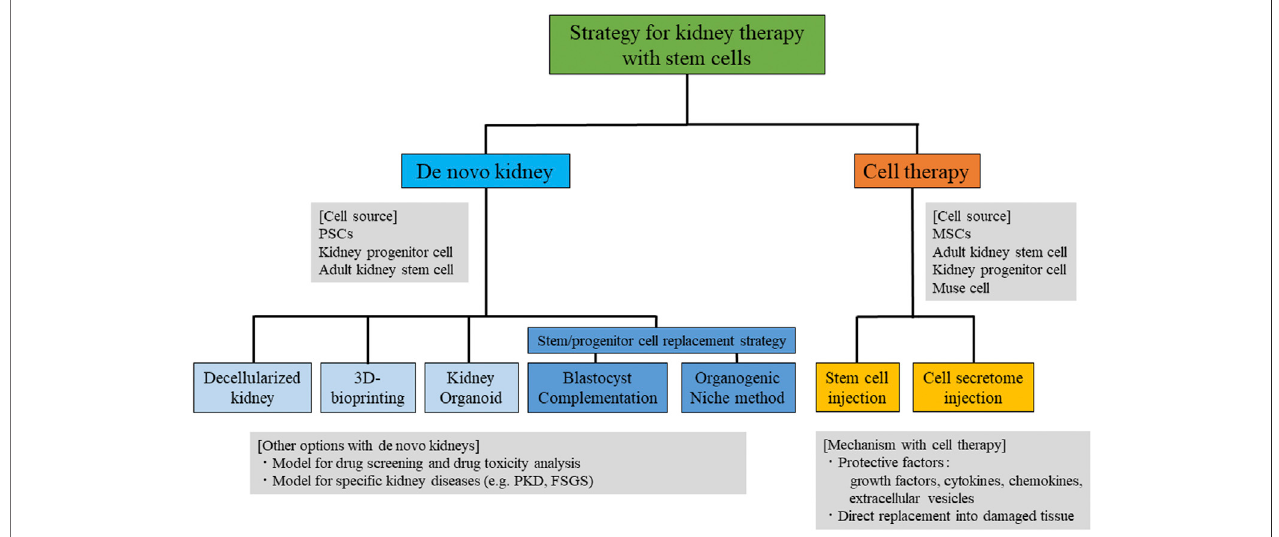
FIGURE 1 | Summary of the strategies for kidney therapy with stem cells. PSCs, pluripotent stem cells; MSCs, mesenchymal stem cells; Muse, multi-lineage differentiating stress -enduring; PKD, polycystic kidney disease; FSGS, focal segmental glomerulosclerosis.